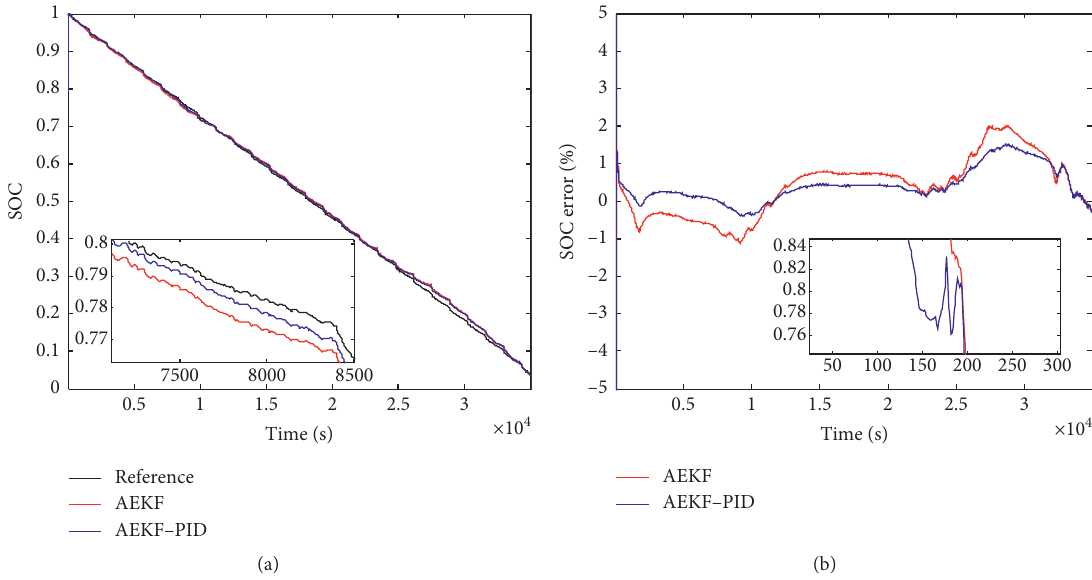
Figure 12: Comparison of SOC estimation under FUDS: (a) SOC estimation result; (b) SOC estimation error.